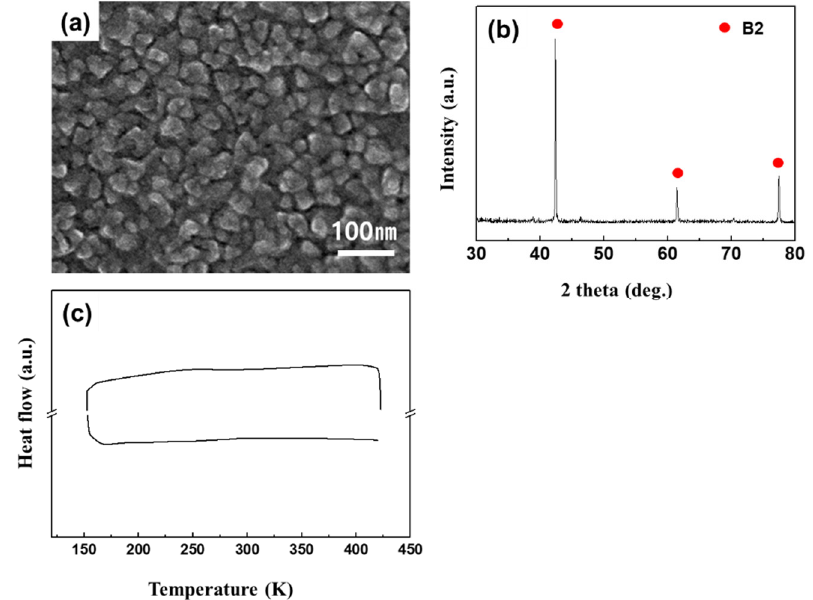
Figure 1. ( a ) Surface image, ( b ) XRD and ( c ) DSC results of Ti-49.8Ni (at %) thin film annealed at 873 K for 1 h. (Deposition condition: growth rate (6.29 nm/min), thickness (1.7 μm), substrate temperature (293 K)).